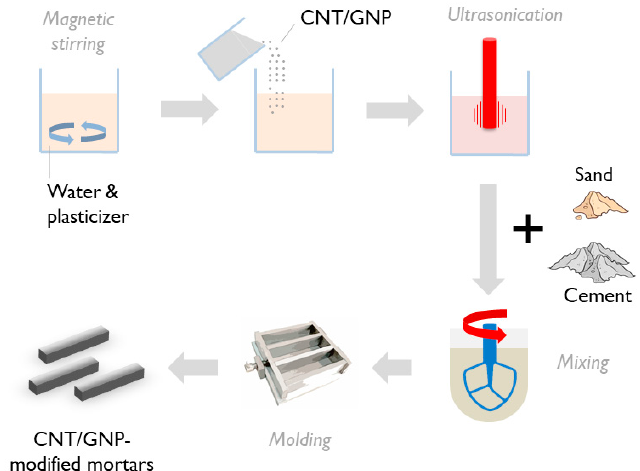
Sensors 2021 , 21 , 933 Figure 1. Schematic of experimental protocol adopted for synthesis of carbon nanotubes (CNT)- and GNP-modified mortars.